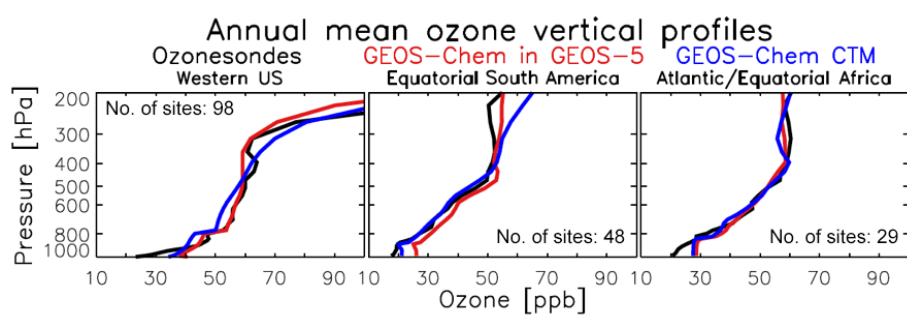
Figure A1. Same as Fig. 5 but for western US, equatorial South America, and Atlantic/equatorial Africa.